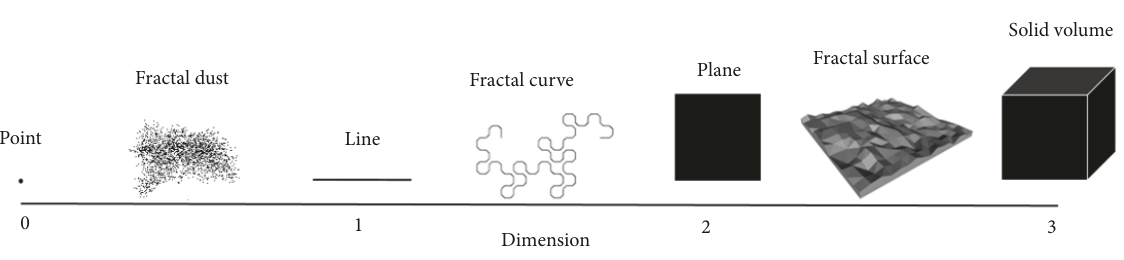
Figure 3: Illustration for conventional (Euclidean) and fractal dimensions.